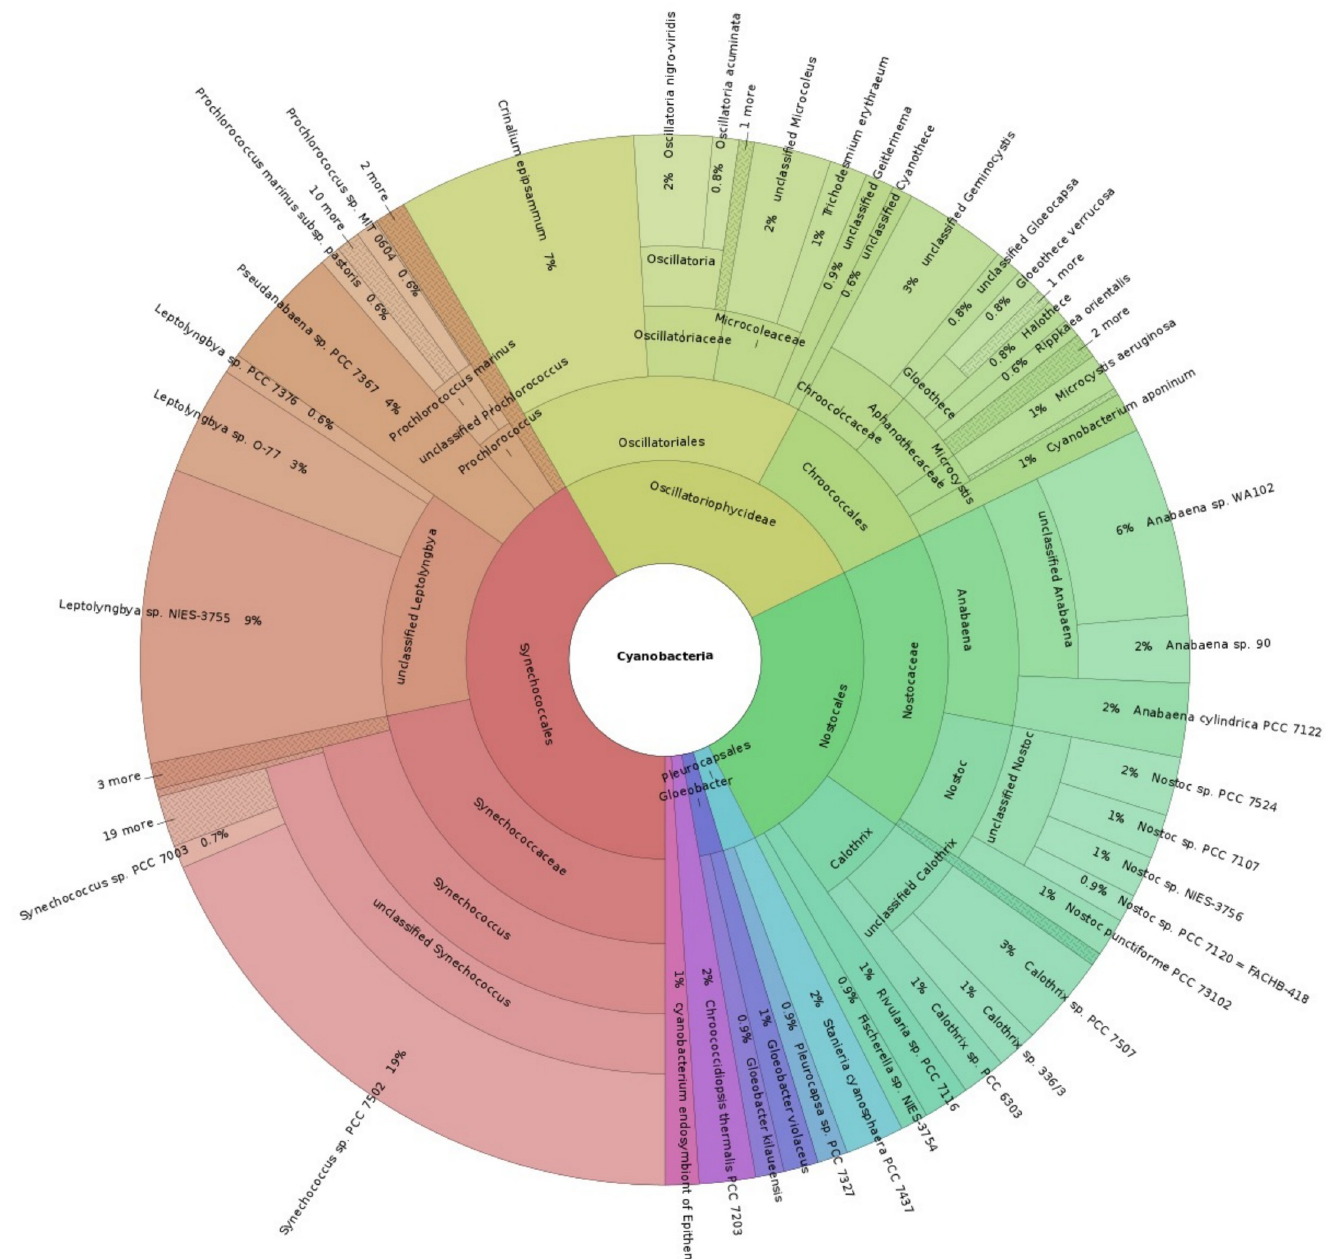
Fig 4. Cyanobacterial taxonomy based on MinION metagenomics sequencing, only reads representing more than 1% occurrence are represented (an interactive diagram is available in S5 File).